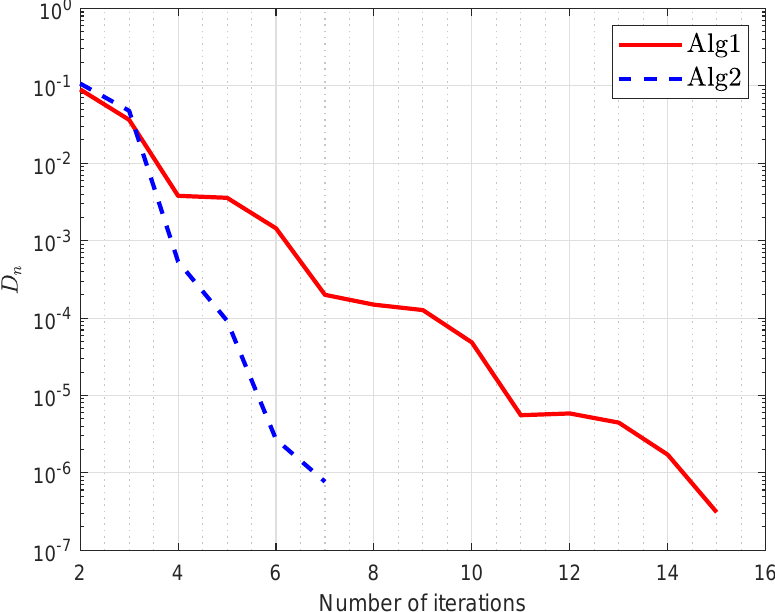
Figure 4. Example 4: Algorithm 1’s numerical comparison with Algorithm 1 in [19] by letting u − 1 = u 0 = ( 2.7,2.0 )